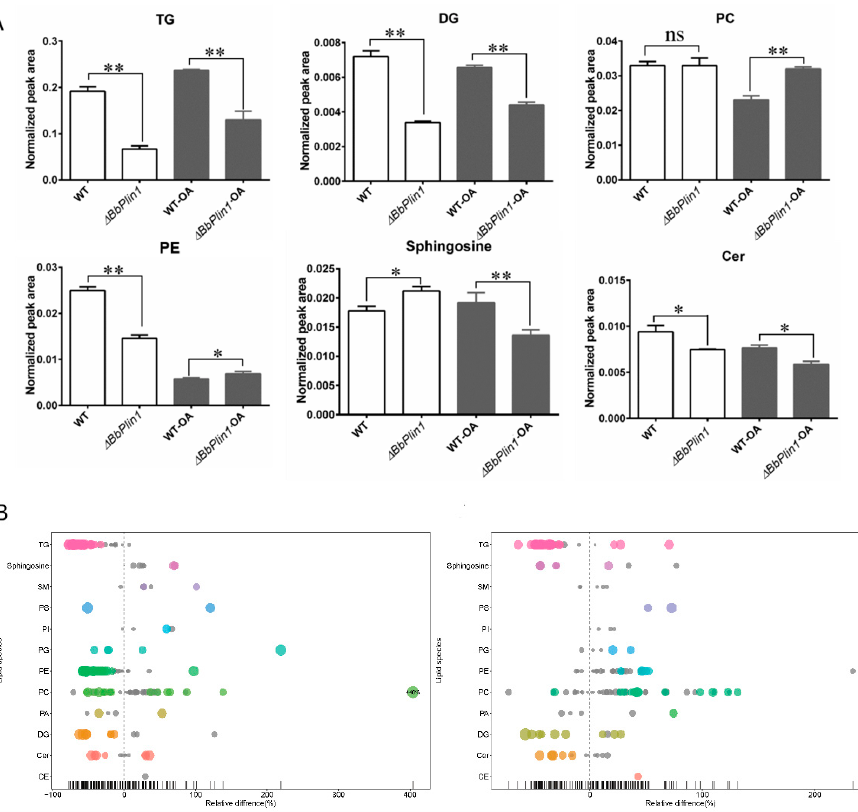
Figure 8. Lipid profiles analyses of B. bassiana wild–type strain and ∆ BbPlin1 conidia harvested